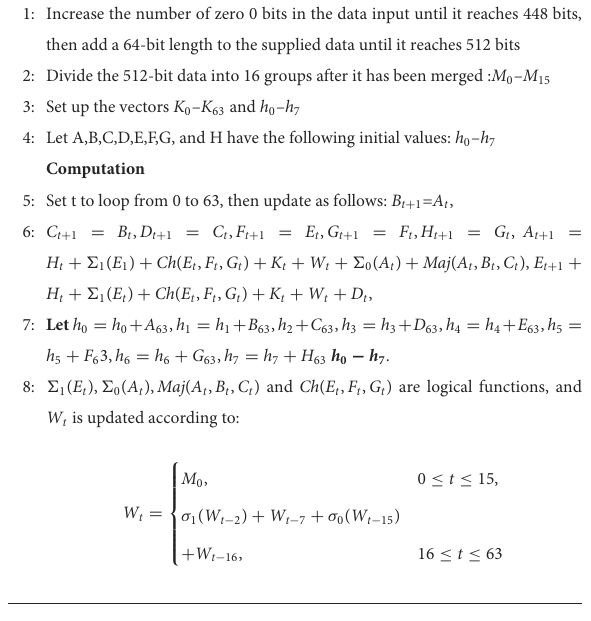
Algorithm 1 SHA256 Crypto Computation Algorithm 2 Blockchain Mining